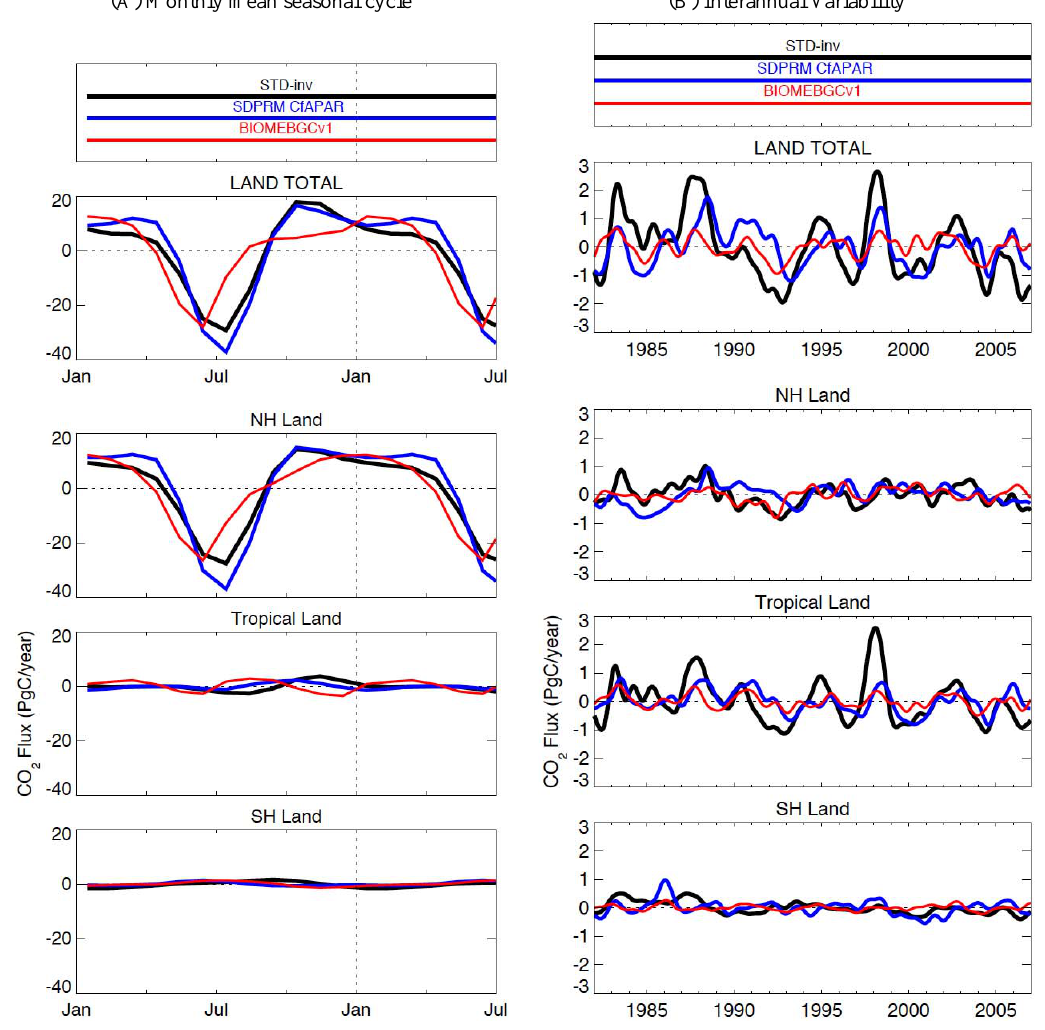
Fig. 6. The comparison between NEE estimates from SDPRM-CfAPAR [Blue], BIOME-BGCv1 [Red], and the land flux estimated by STD-inv [Black] for the monthly mean seasonal cycle (A) and for the interannual variability (B) . The time series are integrated over three latitudinal bands (for the map of the regions see Fig. 3) and de-seasonalized and filtered for interannual variability (as in Rödenbeck (2005)). The fossil fuel emissions have been subtracted from STD-inv